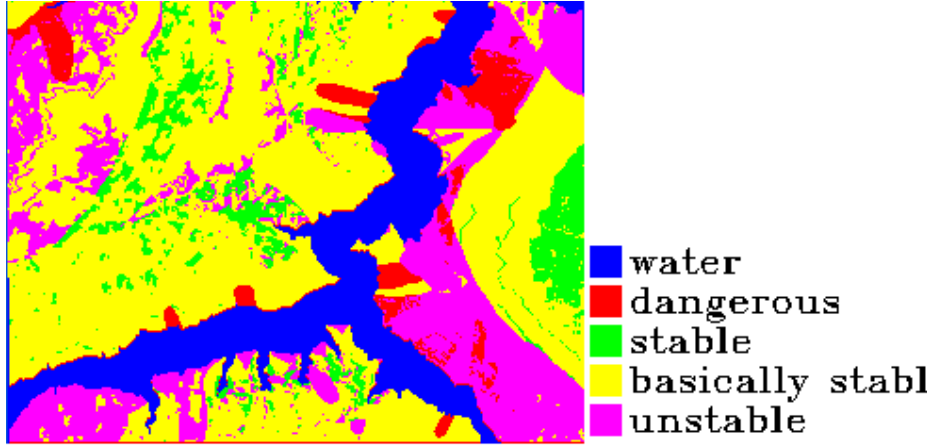
Figure 25. Forecast result of Decision Tree